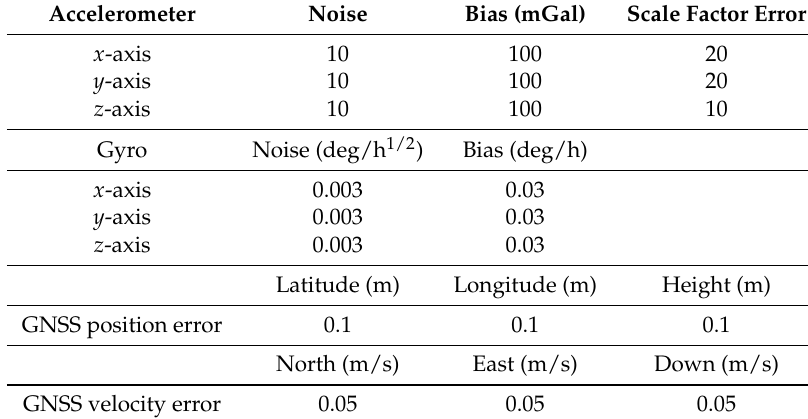
Figure 3. Simulation trajectory. Table 1. Error parameters in